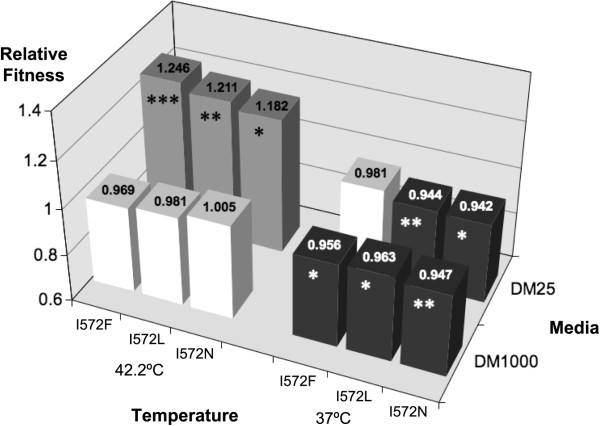
Relative fitness of the rpoB mutants measured in different conditions. The mean relative fitness values are indicated in the top of the bars. The gray color corresponds to an advantageous fitness effect of the mutations in relation to the ancestor, the dark color corresponds to a deleterious fitness effect of the mutations in relation to the ancestor, and the white color corresponds to a neutral fitness effect of the mutations in relation to the ancestor. The asterisks represent a significant difference from a mean fitness of 1.0, based on one-tailed t-distribution with n-1 degrees of freedom. One asterisk represents significance at P < 0.05; two denote significance at P < 0.01; three convey significance at P < 0.001.